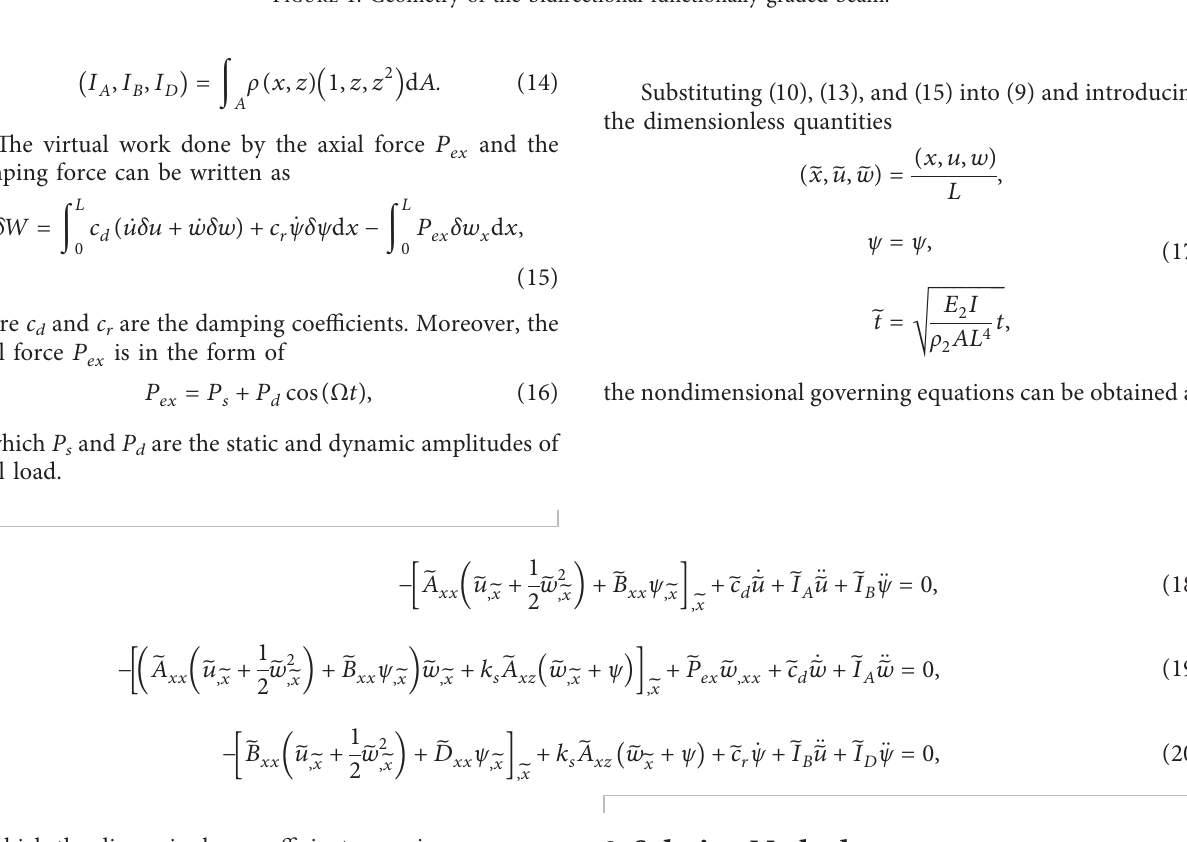
Figure 1: Geometry of the bidirectional functionally graded